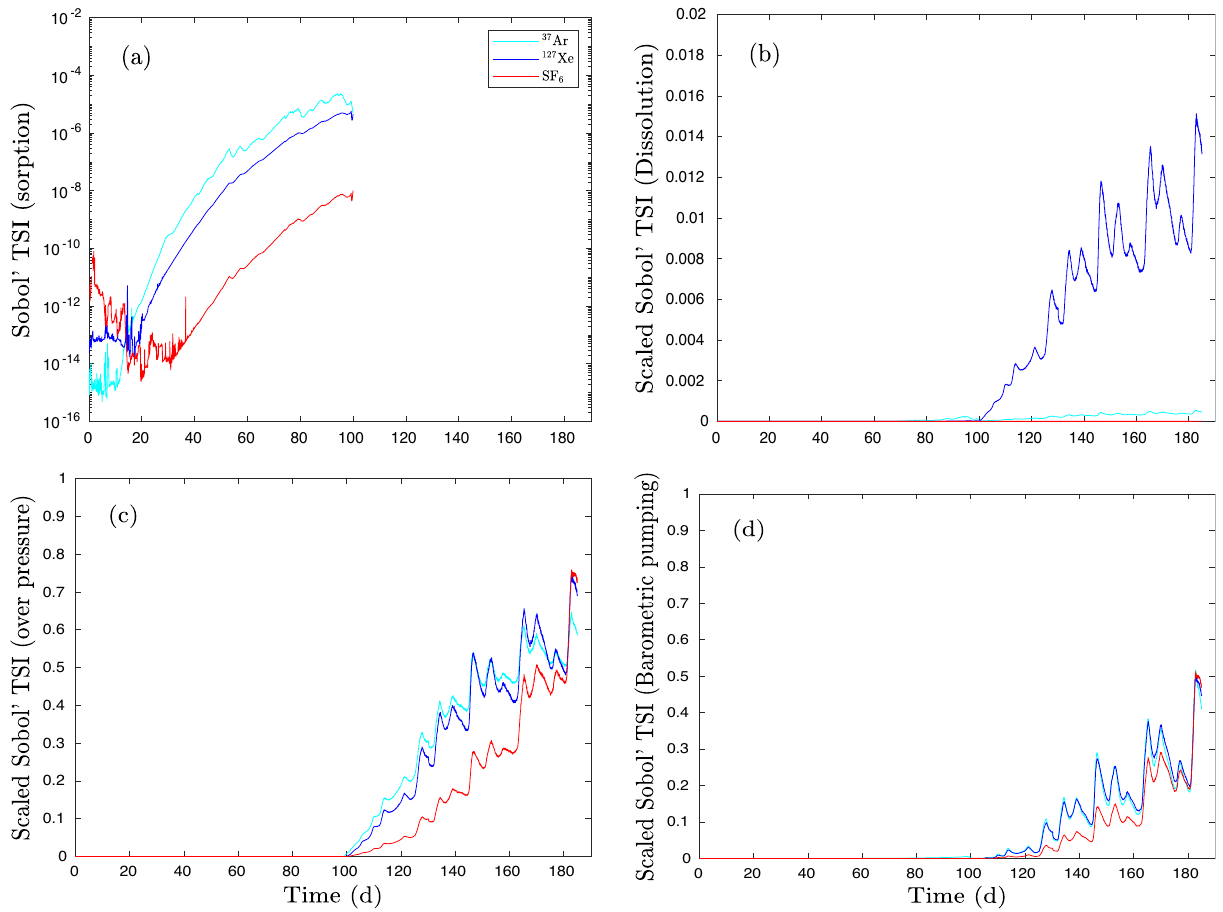
37 127 Ar, Xe, and SF 6 signals at ground surface of the Barnwell system.